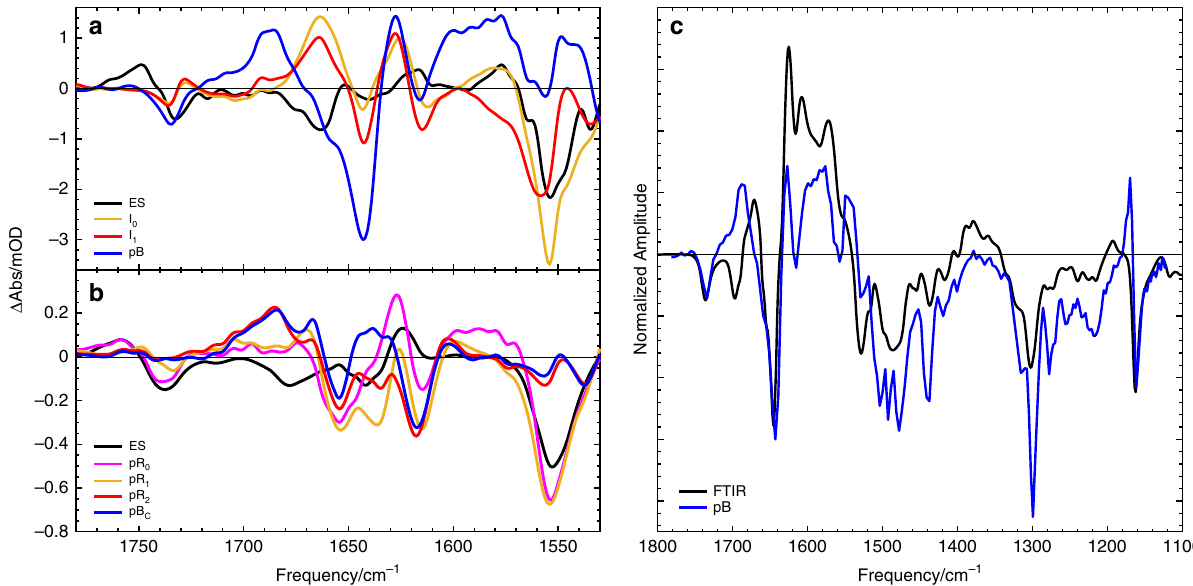
Fig. 7 Species-associated-difference spectra (SADS) in the mid-IR spectral range. The SADS have been resolved from fi tting the target model shown in Fig. 4 to the experimental data, and display the bleached ground state as negative feature and product state absorption as positive feature. a SADS of PYP S , b SADS of PYP C . c An accumulated PYP light-minus-dark difference FTIR spectrum and the SADS of the pB state of PYP in solution (also shown in a ). Absorption changes in the 1740 – 1760 cm − 1 region report on the hydrogen bond interaction between Glu46 and the phenol ring of pCa: higher frequency indicates weakened bond, lower frequency a stronger bond; Absorption changes in the 1690 – 1630 cm − 1 region report on carbonyl stretches with a similar effect of a hydrogen bond on its frequency. The 1555 cm − 1 band has been assigned to pCa C = C stretch and phenol ring modes 50,51,53 , see also Supplementary Table 1.